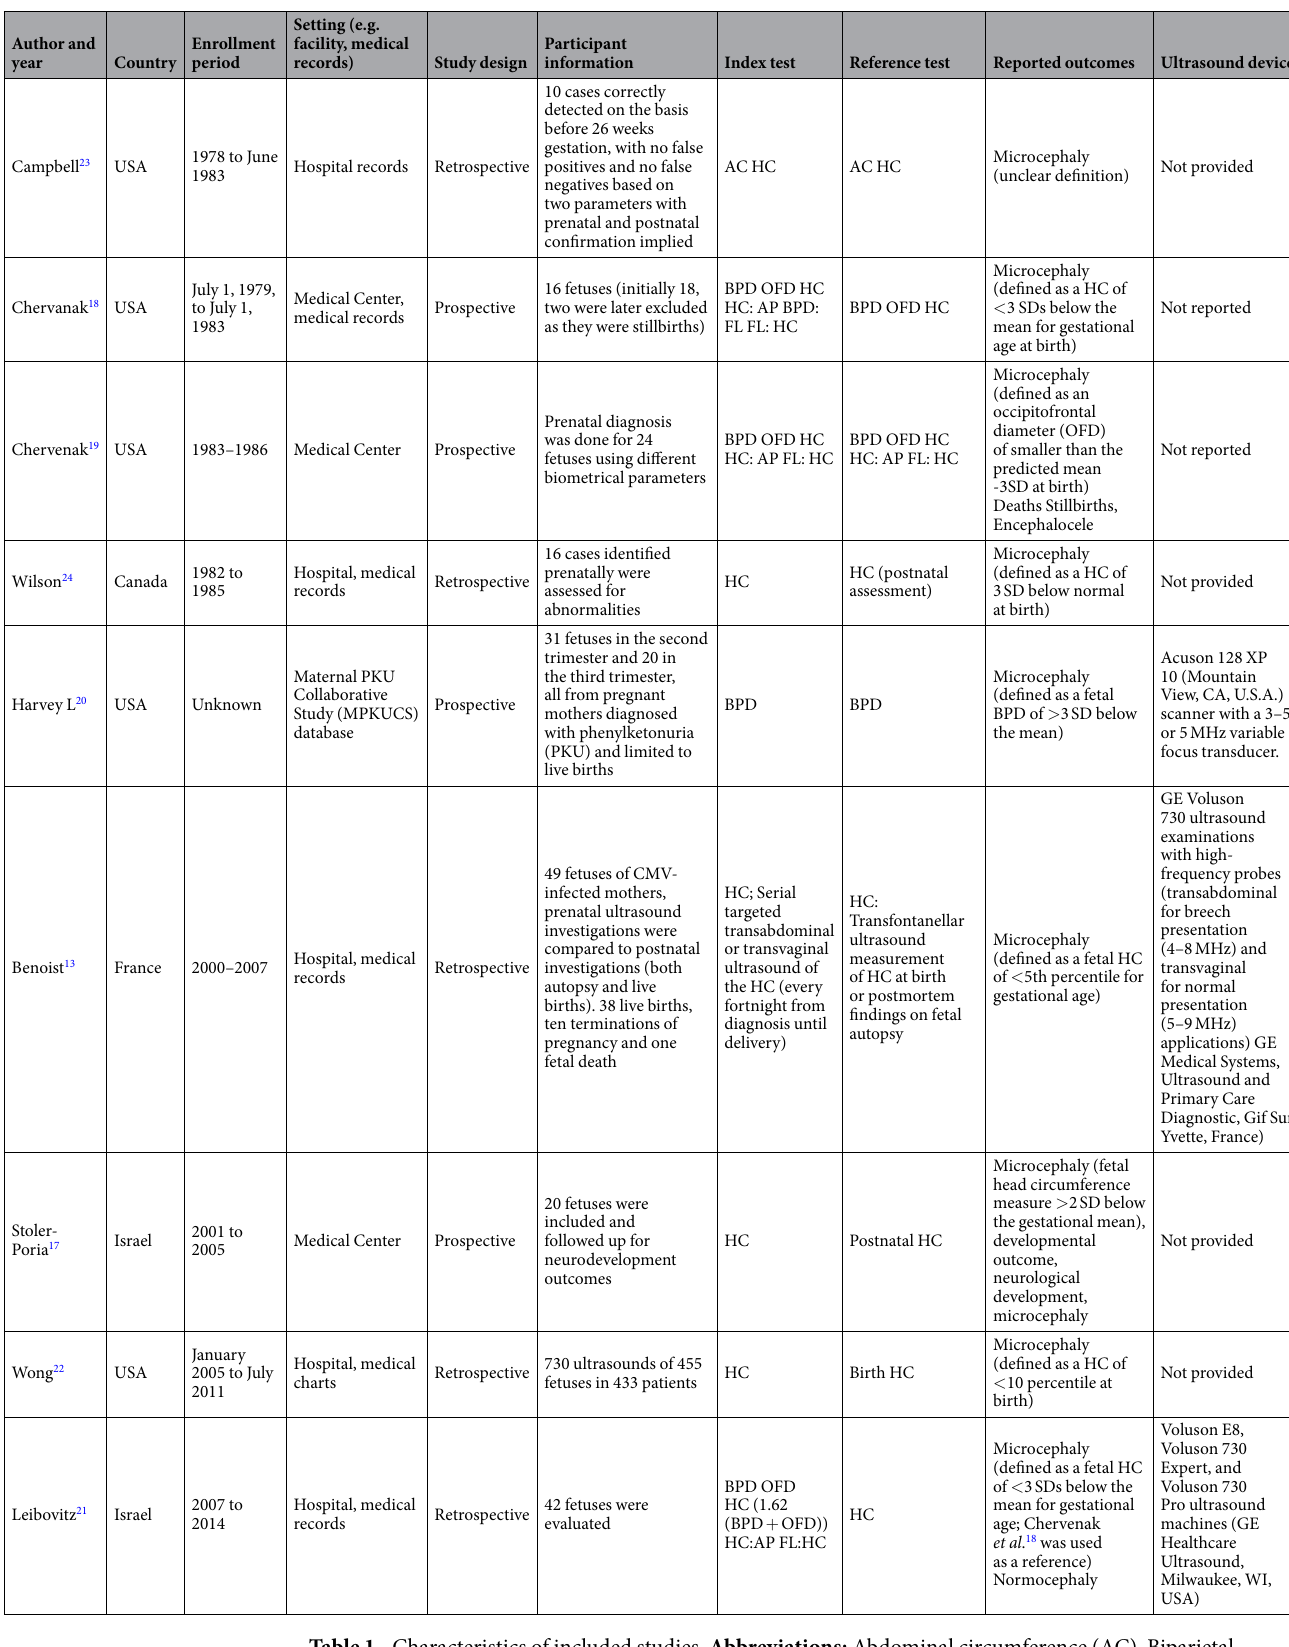
Table 1. Characteristics of included studies. Abbreviations: Abdominal circumference (AC), Biparietal Diameter (BPD), Femur Length (FL), Head Circumference (HC), Microcephaly (MCP), Ultrasound (US), Occipitofrontal Diameter (OFD), Standard Deviation